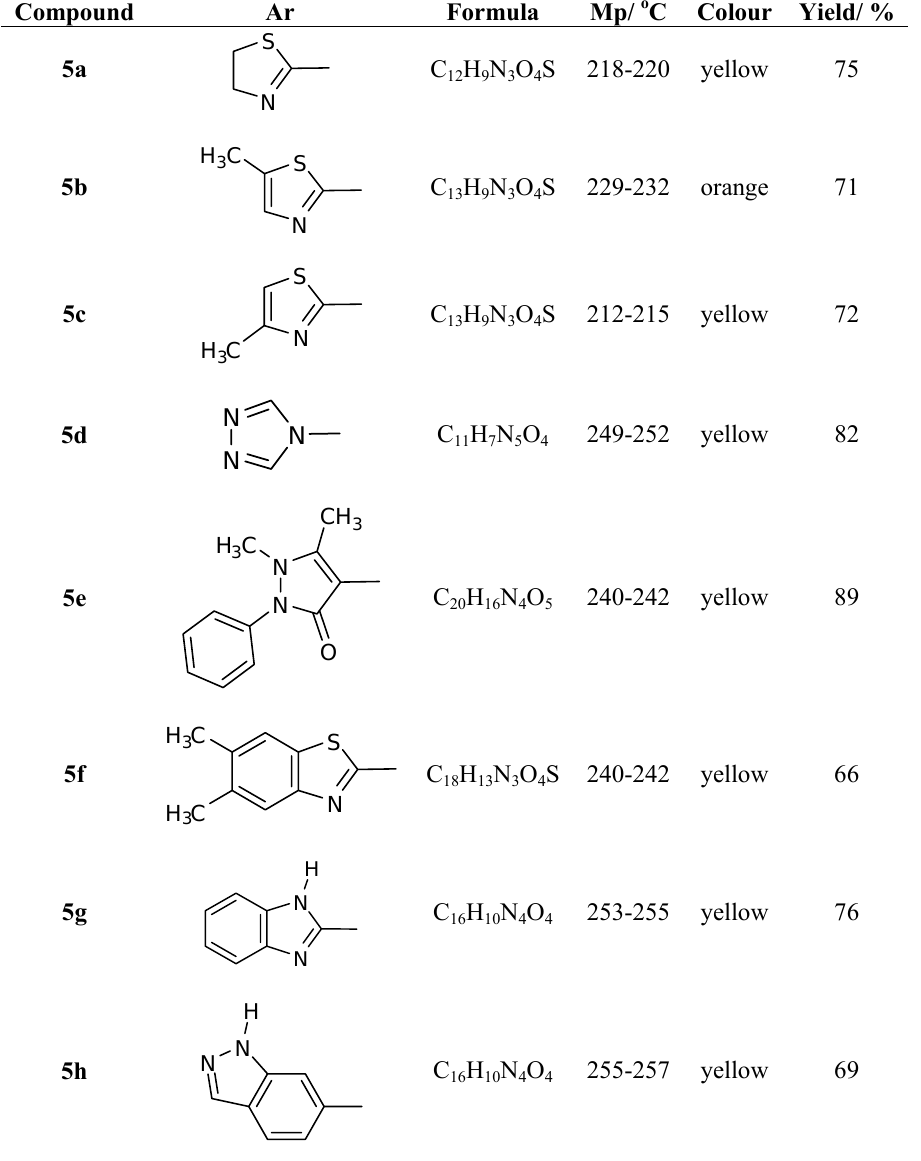
Table 1. Characterization data of 4-heteroarylamino-3-nitrocoumarin derivatives 5a–h . Compound Ar Formula Mp/ o